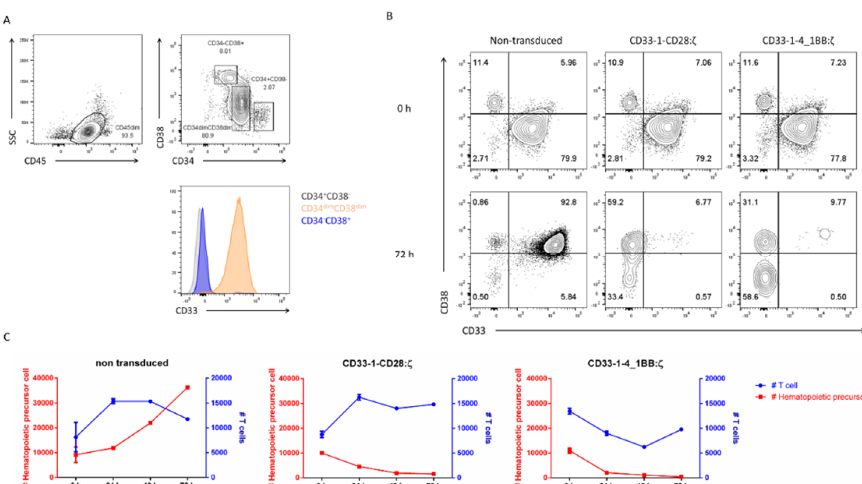
Figure 4. CD33-specific nanoCAR T cells are cytotoxic against CD34 + HPC: ( A ) CD33 expression on CD34 + HPC isolated from cord blood. CD34 + HPC were isolated from cord blood and stained for CD45, CD33, CD34 and CD38. Cells are gated on CD45 dim SSC lo and CD34 + CD38 − , CD34 dim CD38 dim and CD34 − CD38 + . Plots are representative for 5 donors; ( B ) Cytotoxicity in time. NanoCAR T cells were incubated with CD34 HPC for 72 h. CD38 and CD33 expression on CD34 + HPC measured at the start (zero hour) and the end (72 h) of the experiment; ( C ) Cytotoxicity in time. NanoCAR T cells were incubated with CD34 HPC for 72 h. At distinct time points, we measured the presence of T cells and HPC (gated on CD3 − ) by flow cytometry. Data points shown are the means, and error bars represent the SEM taken from a representative experiment. The experiment was performed two times, each time with two different donors.